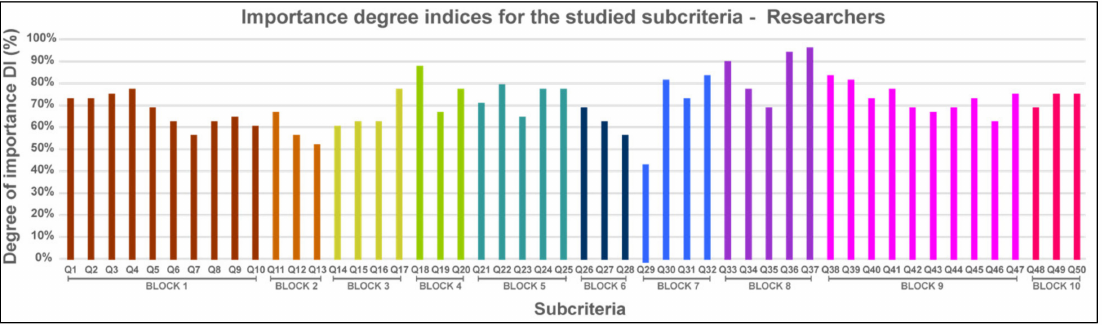
Figure 3. Bar chart showing the degree of importance (DI) of all criteria analysed (Q1 to Q50) by academia experts only. Own elaboration.